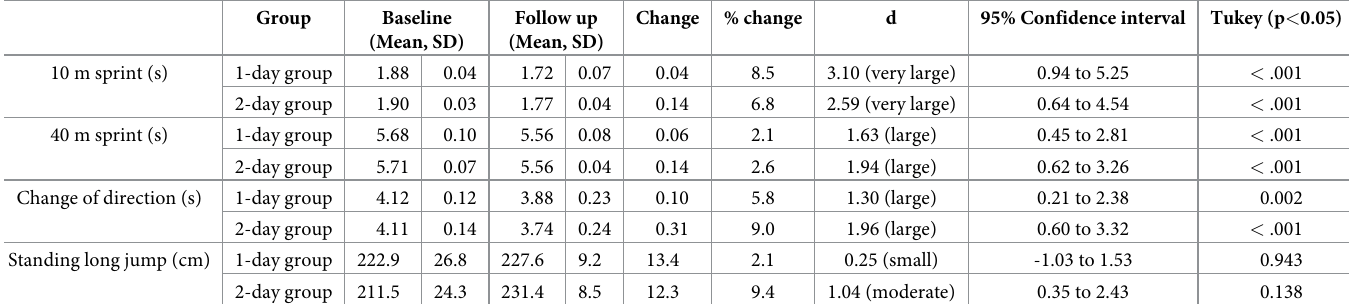
Table 3. Results of the 1-day vs 2-day